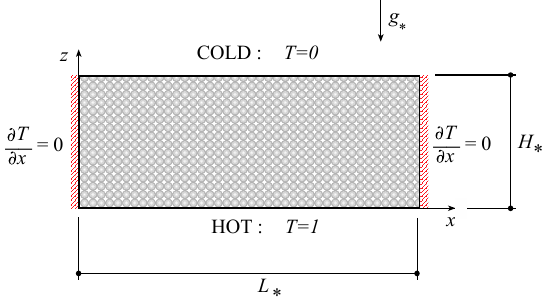
Figure 1. A rectangular fluid-saturated porous domain heated from below [8,10,14]. (Reproduced